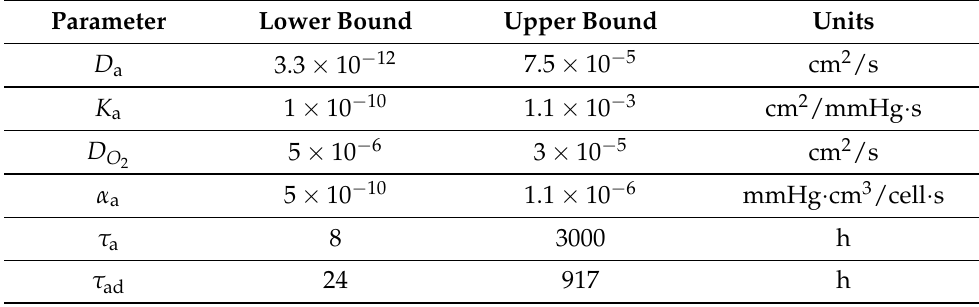
Table 2. Parameter ranges considered in the